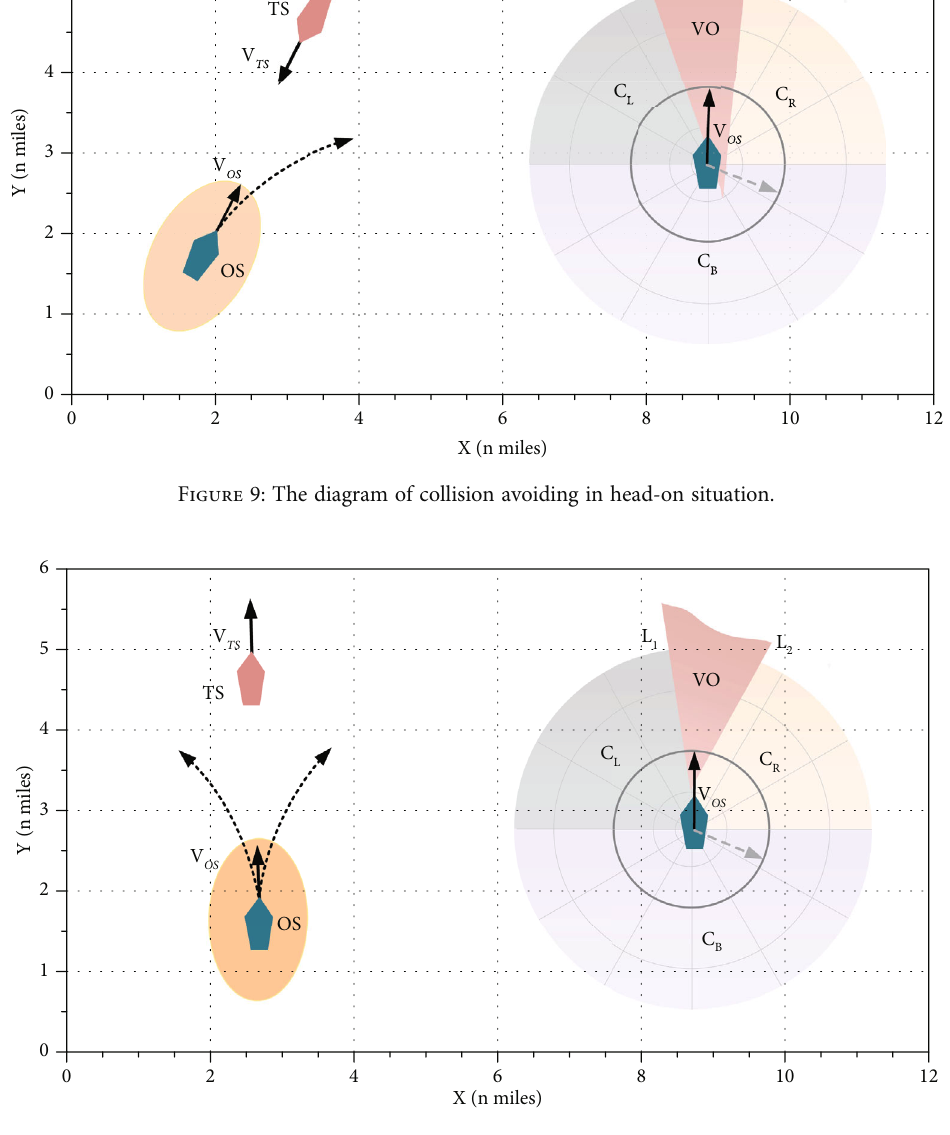
Figure 10: The diagram of collision avoiding in overtaking